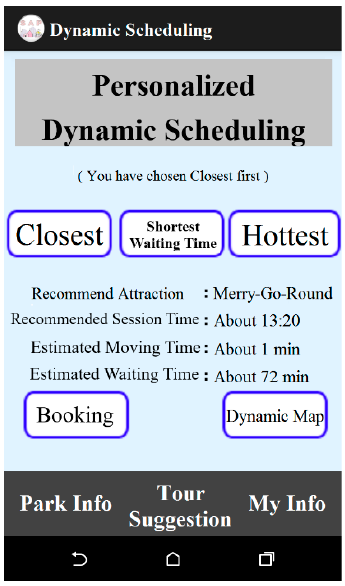
Figure 7. Experimental results of the Closest First strategy.